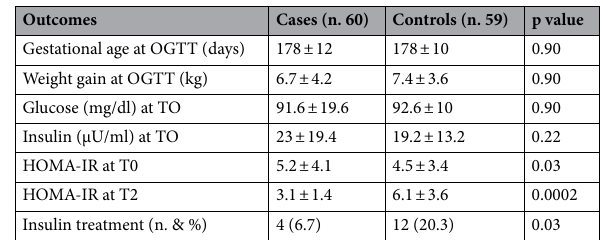
Table 2. Primary and metabolic outcomes.